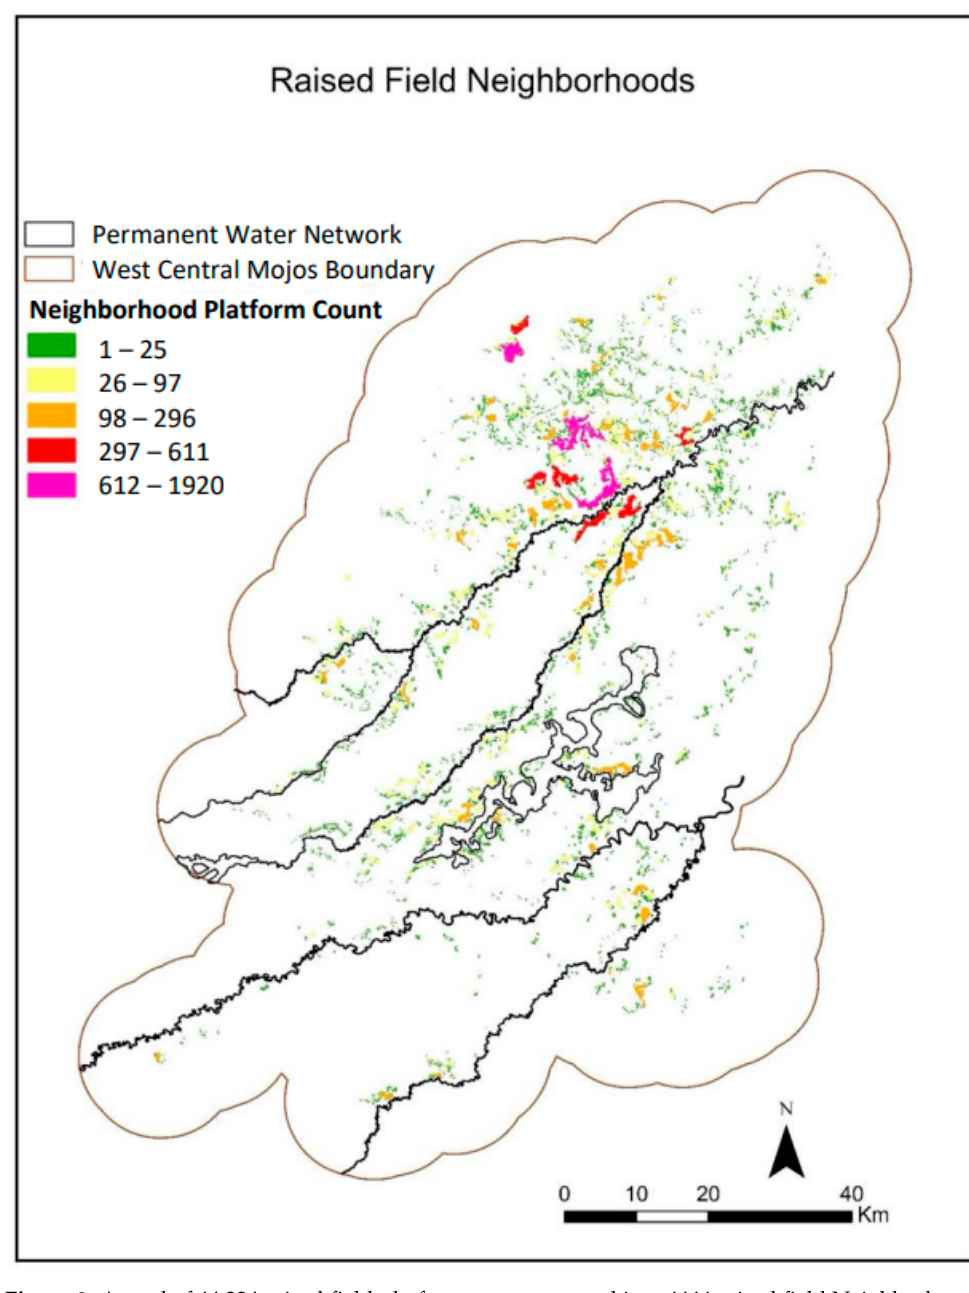
Figure 3. A total of 44,224 raised field platforms were grouped into 4444 raised field Neighborhoods. To be in the same Neighborhood, platforms must be within 40 m of at least one other platform in the same Neighborhood. Platforms were not assigned to more than 1 Neighborhood.